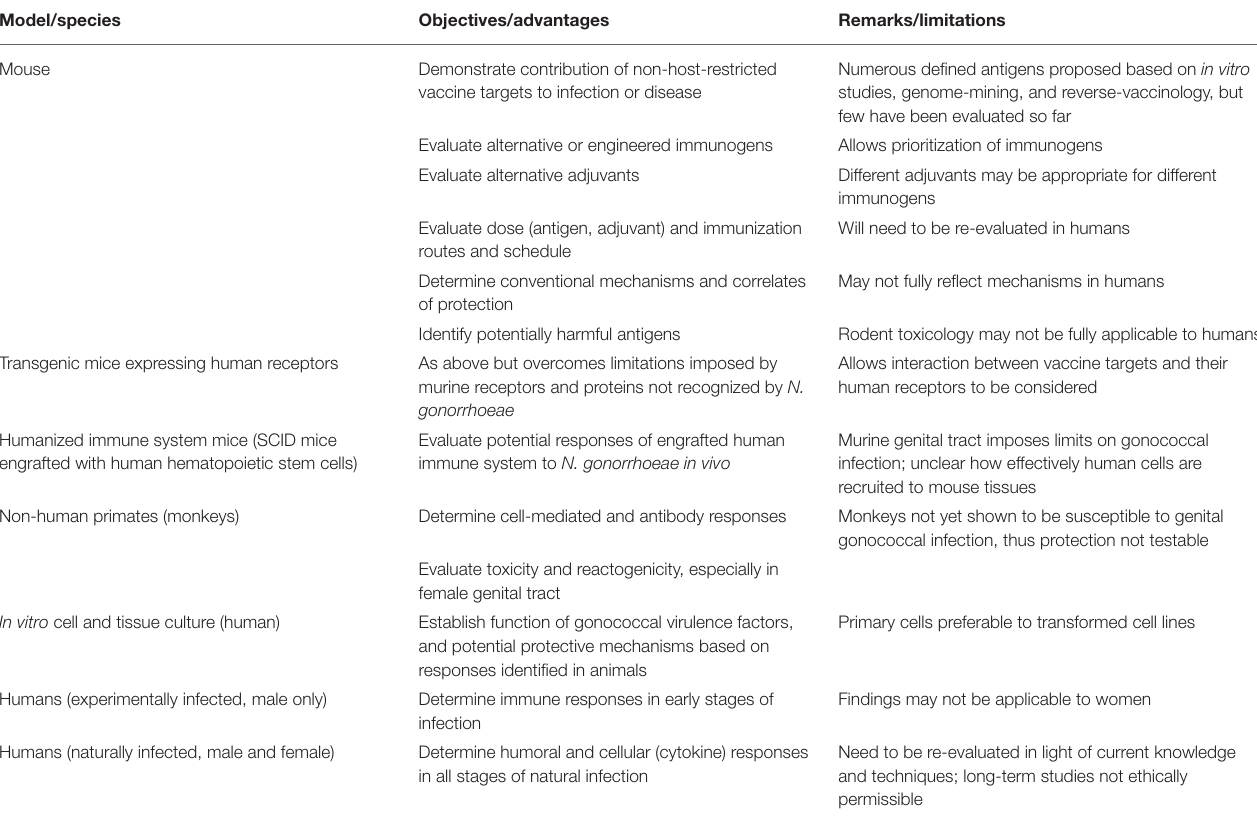
TABLE 2 | Pre-clinical models and pathway for gonococcal vaccine development.